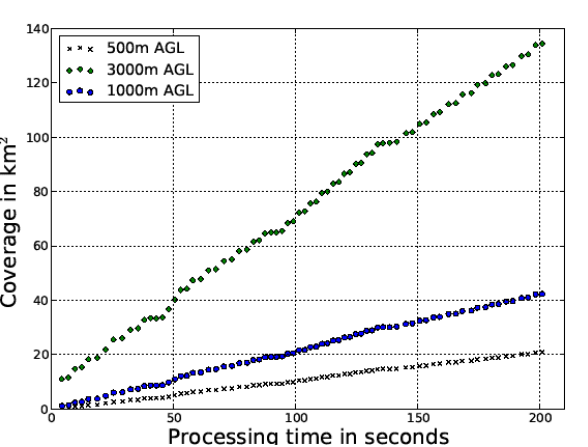
Figure 3. Coverage of onboard processed orthophotos as a function of processing time during a